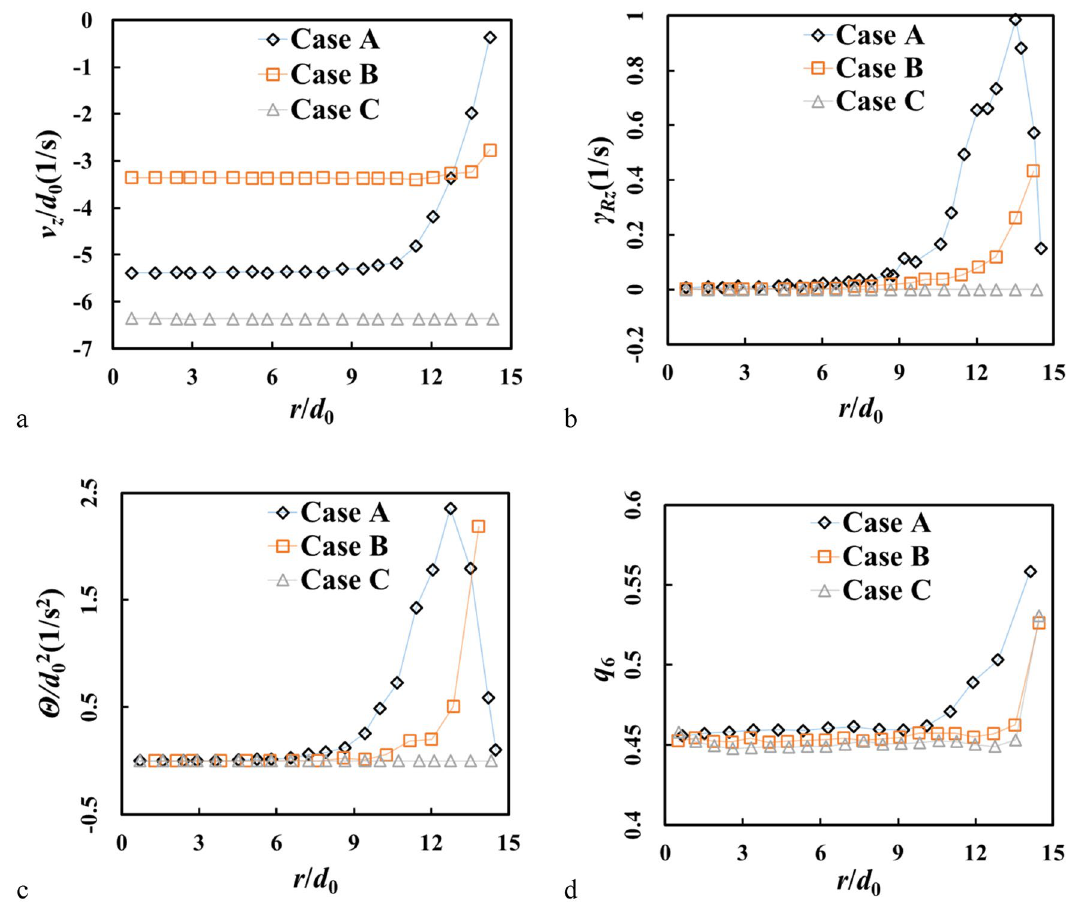
Figure 4. Radial profiles of ( a ) vertical velocity v z , ( b ) shear rate, ( c ) granular temperature, ( d ) orientational order q 6 at z = 100 d 0